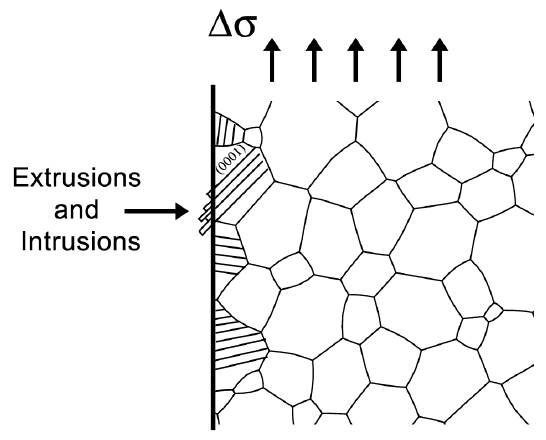
Figure 9. Schematic representation of PSB formed in a crystal grain that has an unfavorable orientation of its (0001) slip planes relative to the planes of maximum applied shear stresses.